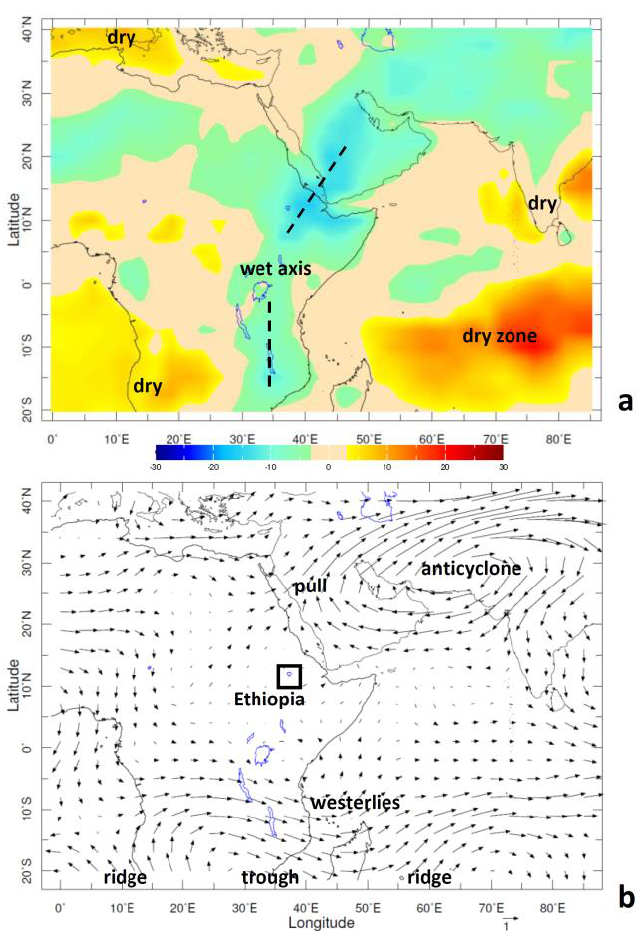
Figure 4. Composite differences of 5-most minus 5-least ‘Wide’ seasons: ( a ) satellite net outgoing long-wave radiation (OLR) and ( b ) 1000–100 hPa tropospheric circulation vectors with key features, and an index box.